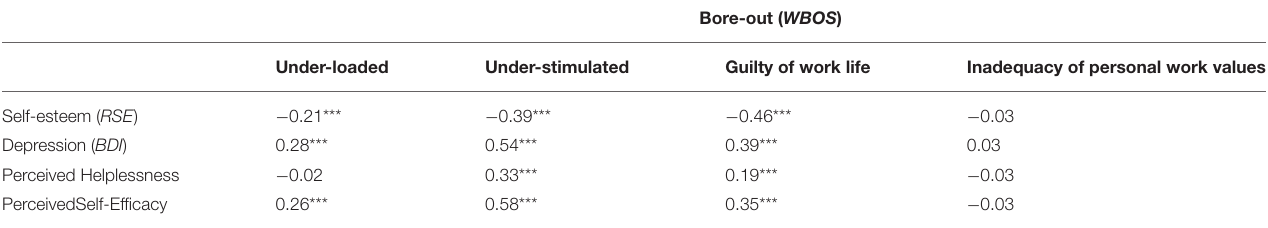
TABLE 4 | Bivariate correlations.